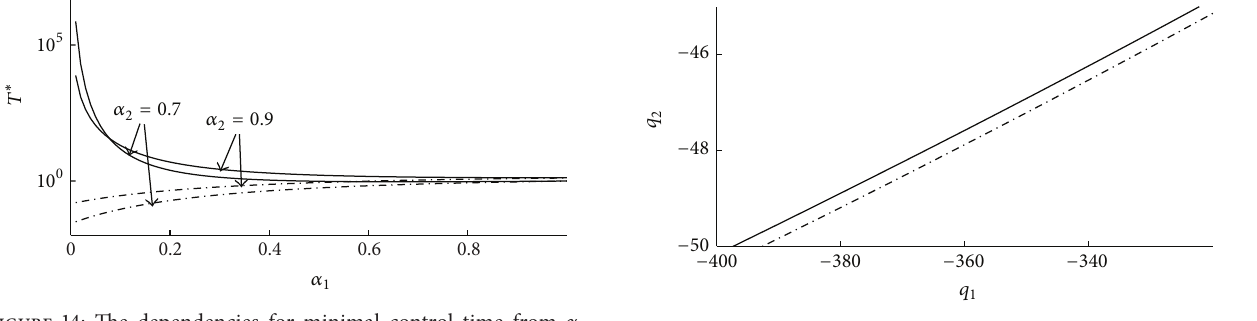
Figure 17: The boundary trajectories for double integrator of fractional order at 𝛼 1 = 𝛼 2 = 0.5 and 𝑙 = 1 .